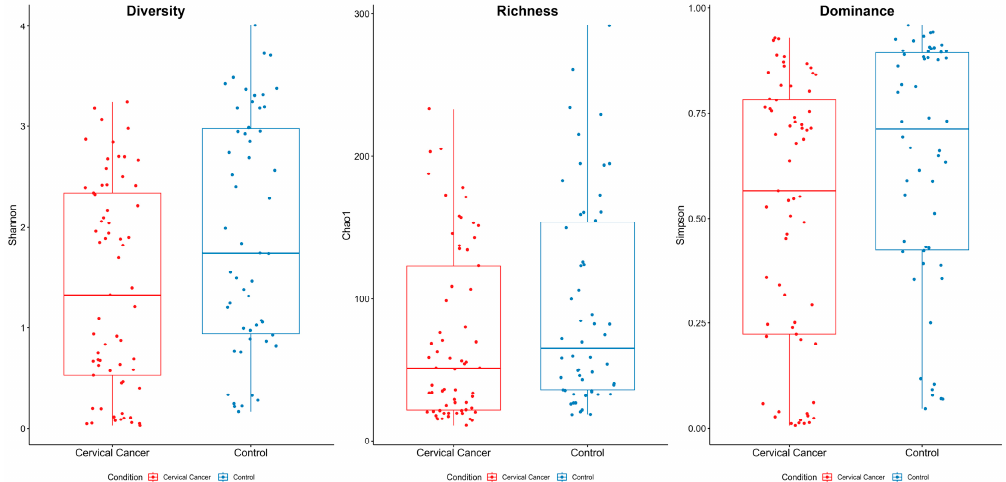
Figure 4. Line plot representing the taxonomic abundance at species level across the different groups (cervical cancer—left; healthy control—right).